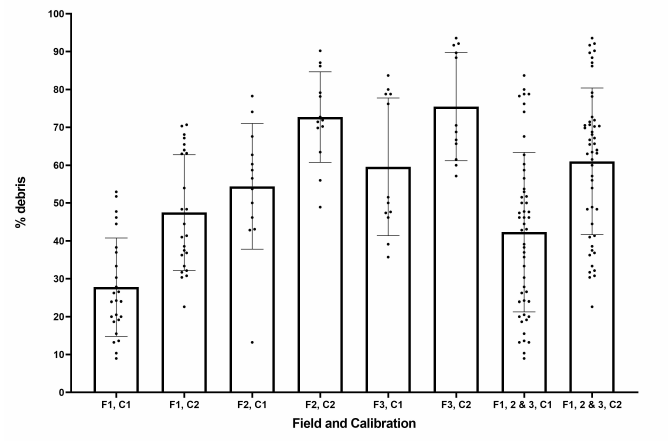
Figure 13. Proportion of objects identified which are debris for each field (F1–3) and calibration (C1, C2). Field 1 had the lowest proportion of misidentified targets, due to its higher number of weeds/frame (average of 43 weeds/frame). The larger number of weeds, if average debris